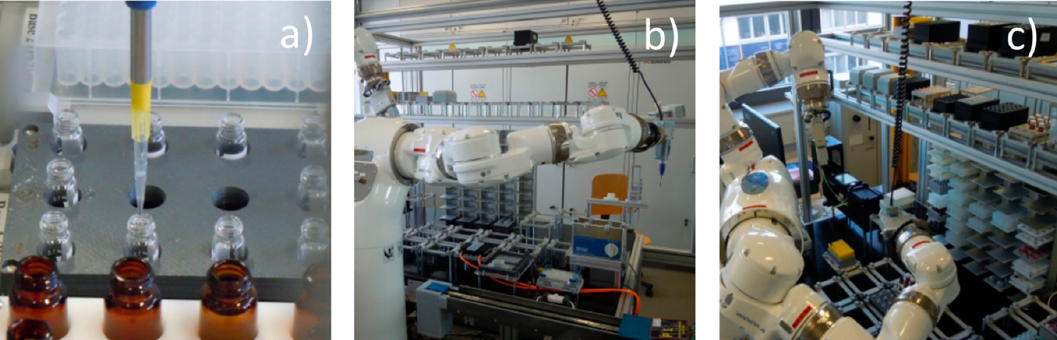
Figure 9. Pipetting steps: ( a ) Liquid dispensing in vial (vol. 2 mL), ( b ) tip ejection into waste container, ( c ) position after the robot jobs, PICKUP and RELOAD, for safe tip load or placing the pipette.